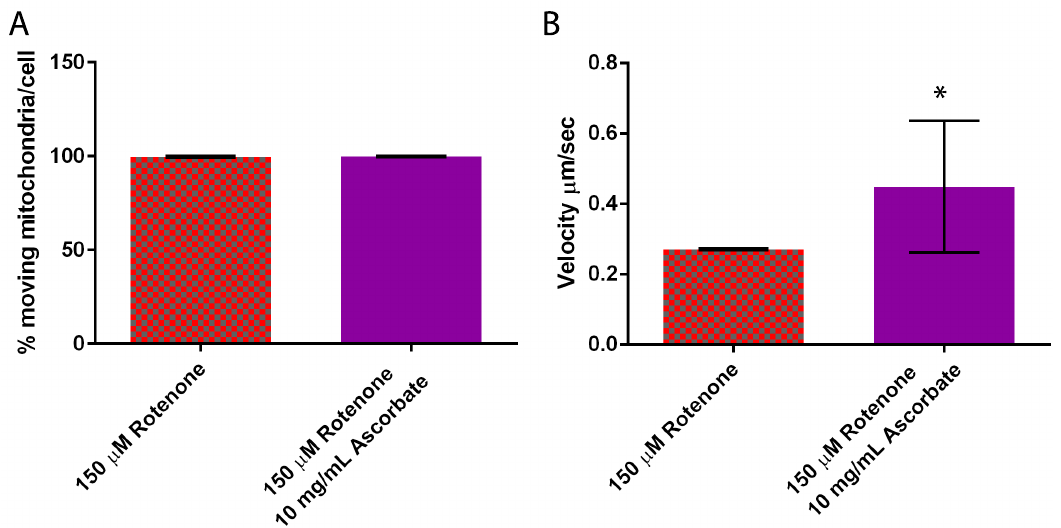
Figure 8. Mitochondrial motility in cells treated with rotenone and the antioxidant ascorbic acid. ( A ) Percent moving mitochondria remained unaffected, ( B ) while ascorbic acid significantly increased velocity by 55% when compared to rotenone treated cells ( p = 0.0131) ( n = 50). Standard error is represented by error bars. * indicates significant difference between